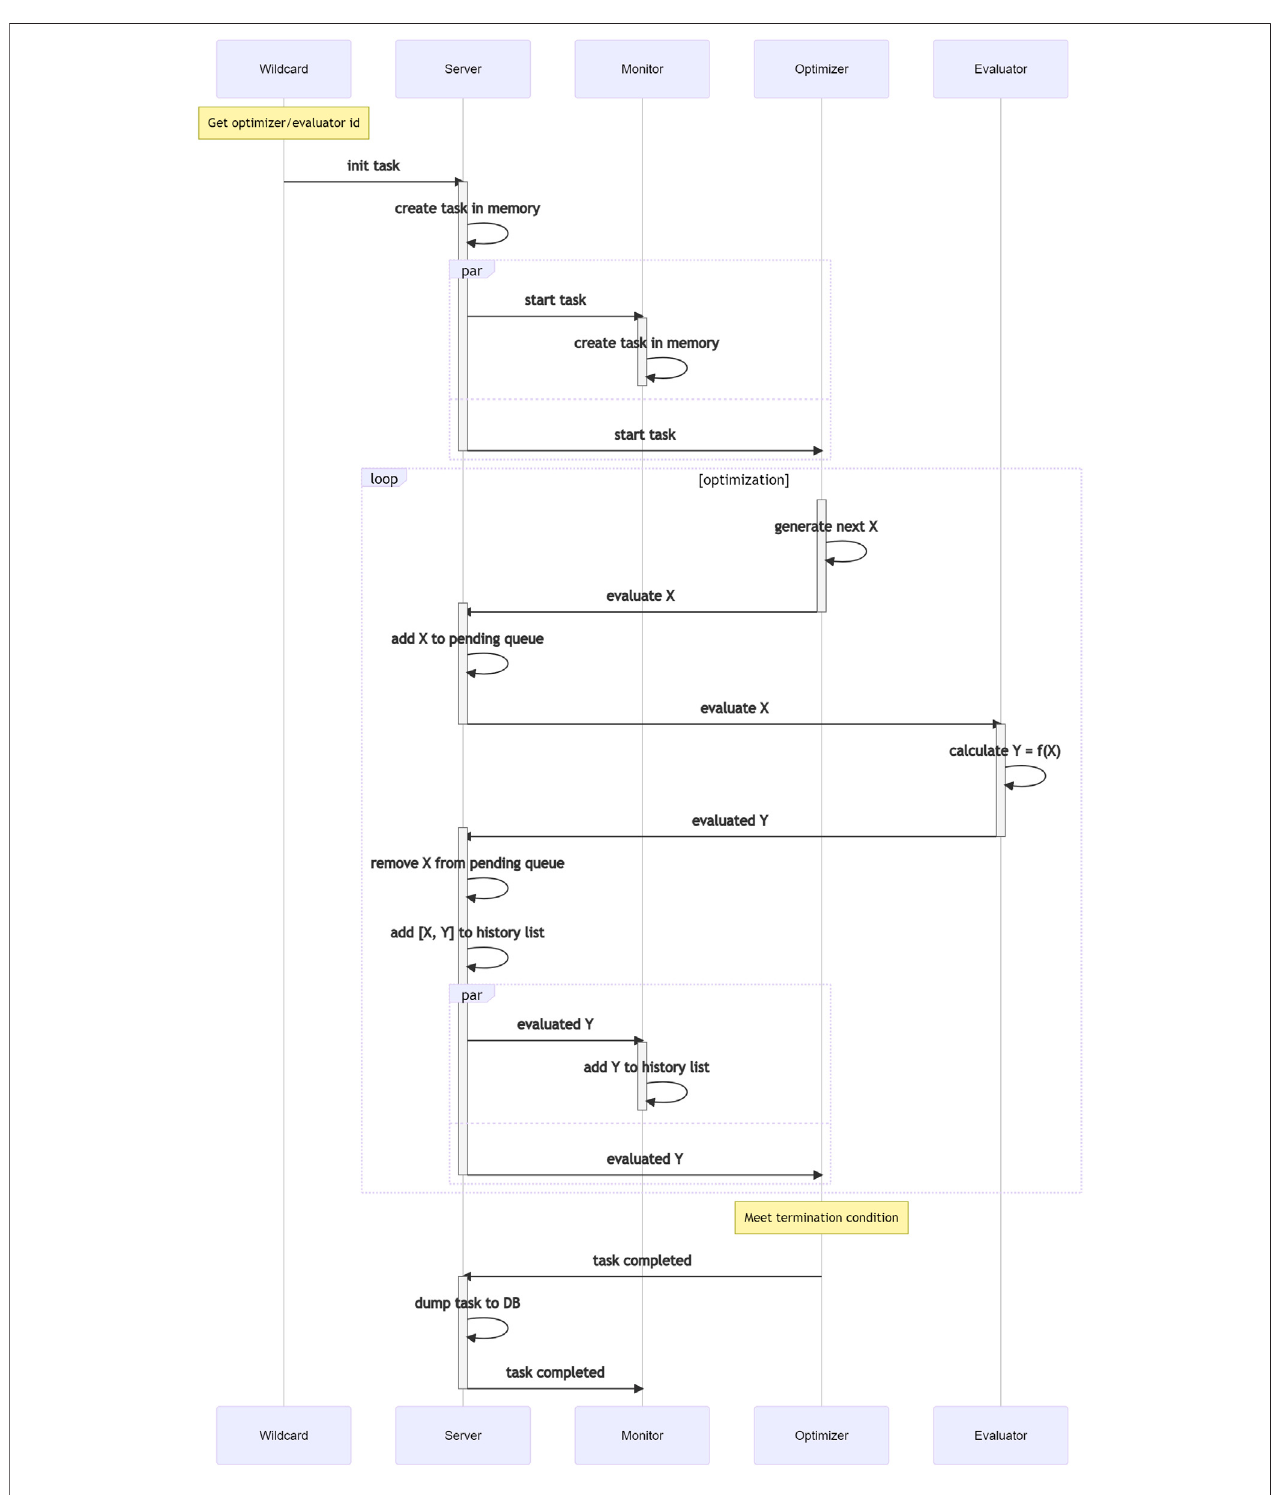
FIGURE 5 | Task-based optimization data- fl ow in Teeport.